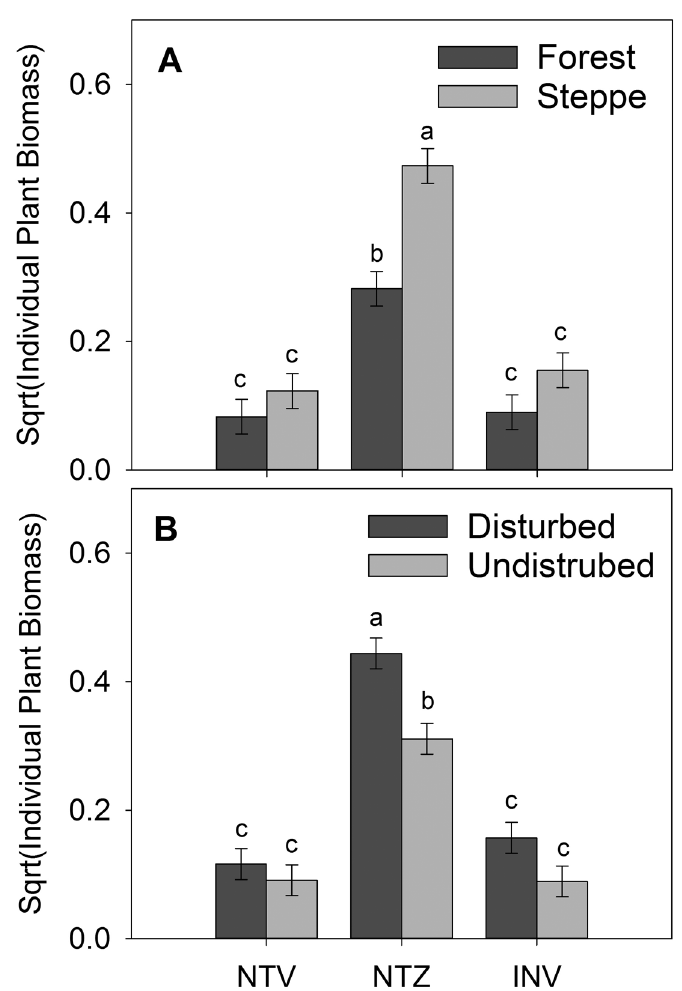
Figure 3. Effect of habitat ( A ) [Forest versus Steppe] and disturbance ( B (Disturbed [“Dist+”] versus Undisturbed [“Dist-”]) on the average individual biomass of native (“NTV”), naturalized (“NTZ”), and invasive (“INV”) plants in each plot as of July 2012. Individual plant biomass estimates were square root- transformed prior to analysis and responses are reported as least square means estimates ± SE. Values are derived solely from seed addition (SA+) plots to insure comparisons were conducted between individuals with similar durations of residence time within each plot. Post hoc multiple pairwise comparisons were conducted with the Tukey-Kramer method; different lowercase letters indicate significant differences at a Type I error =